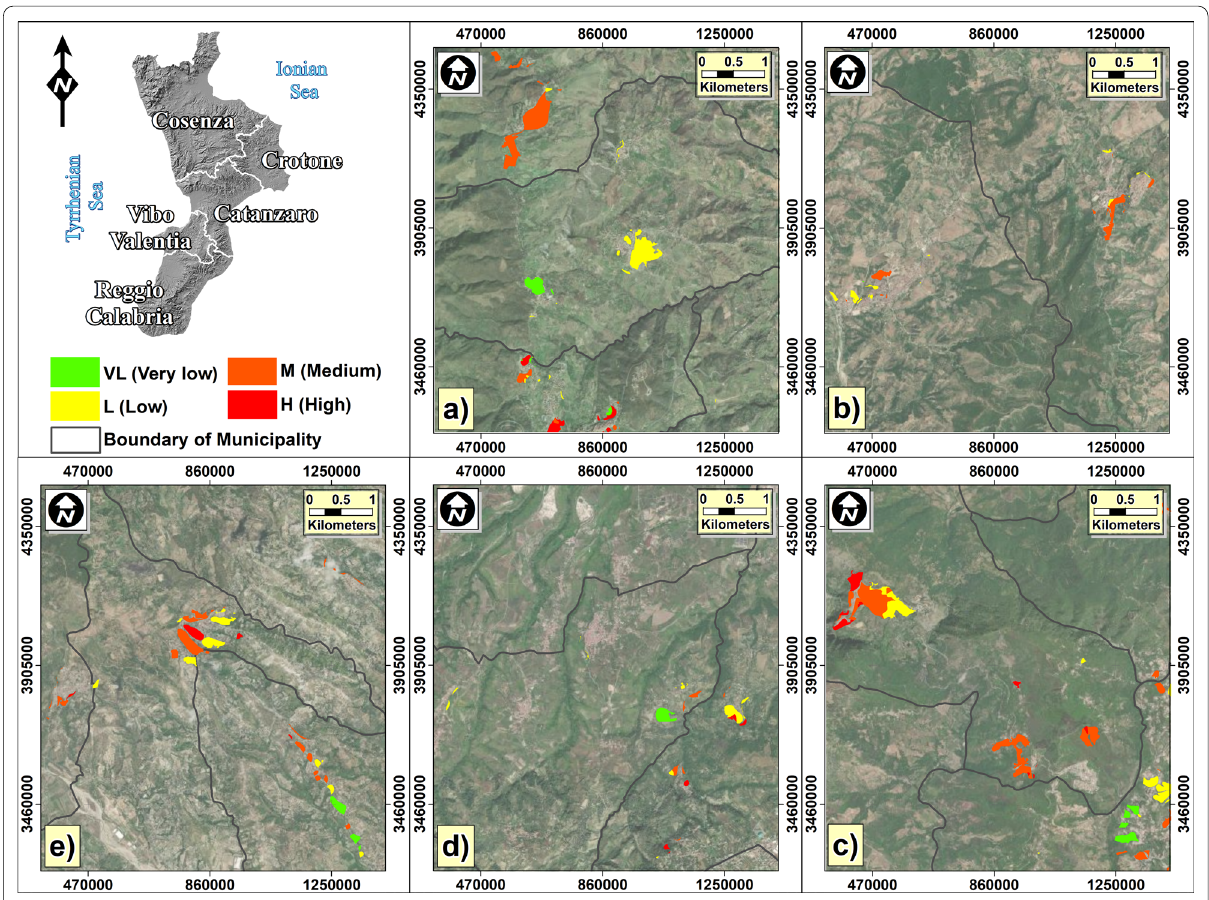
Fig. 11 An example of VAs distinguished according to the results of the Lithological consistency matrix . The sample areas correspond to the ones identified in Fig. 8 (white boxes) for the Provinces of: a Cosenza, b Crotone, c Catanzaro, d Vibo Valentia and e Reggio